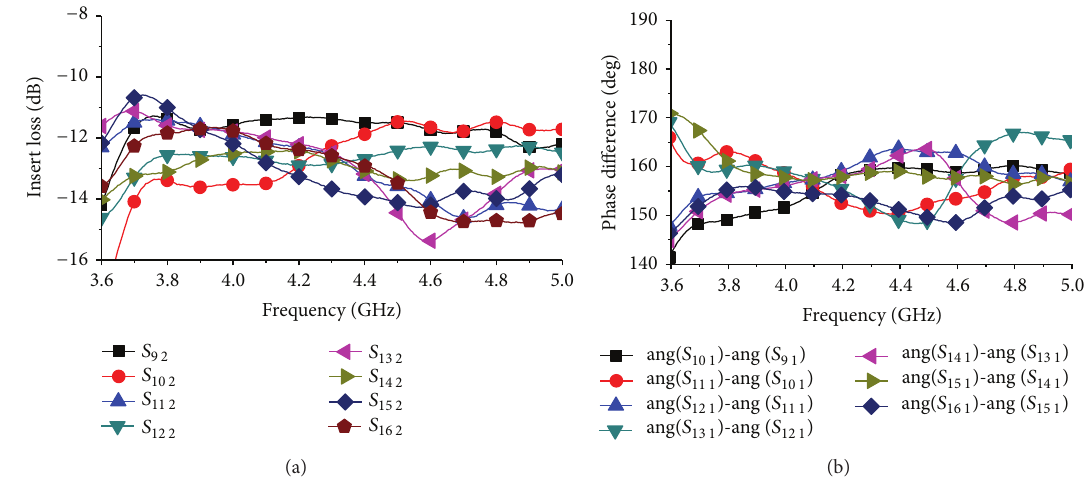
Figure 10: The measured results of insertion loss (a) and phase difference (b) at Port 2. The phase difference at Port 2 is 157.5 ∘